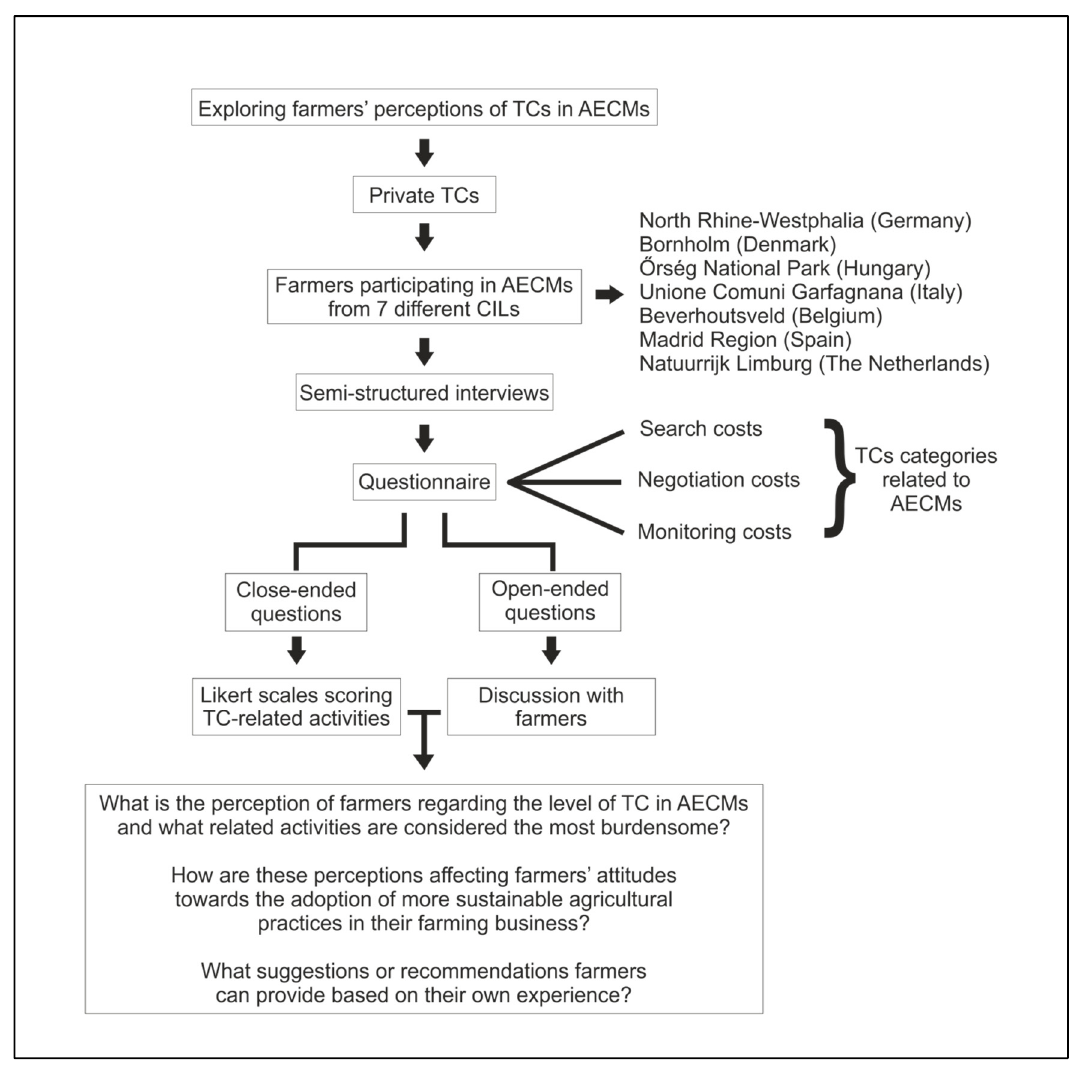
Figure 1. Qualitative design used to explore the perceptions of farmers about transaction costs in AECMs.